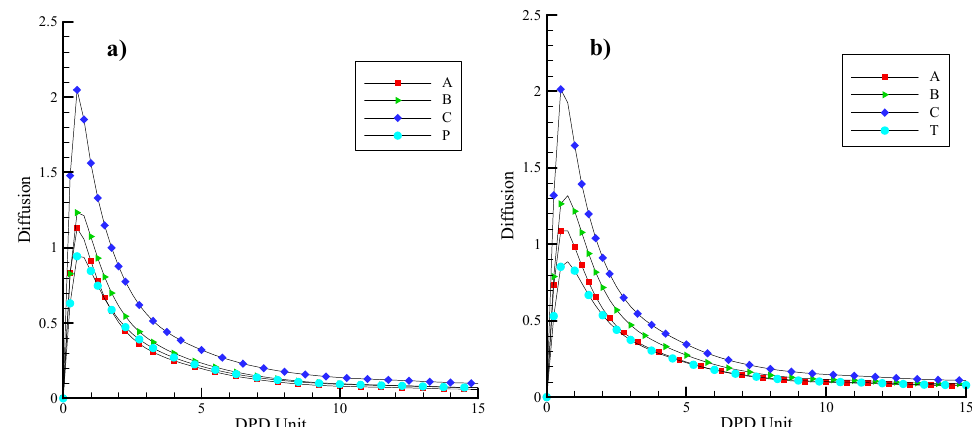
Figure 5. Diffusion rates of the beads for ( a ) Nafion/PVPA blend membranes, ( b ) Nafion/PVTri blend membranes.